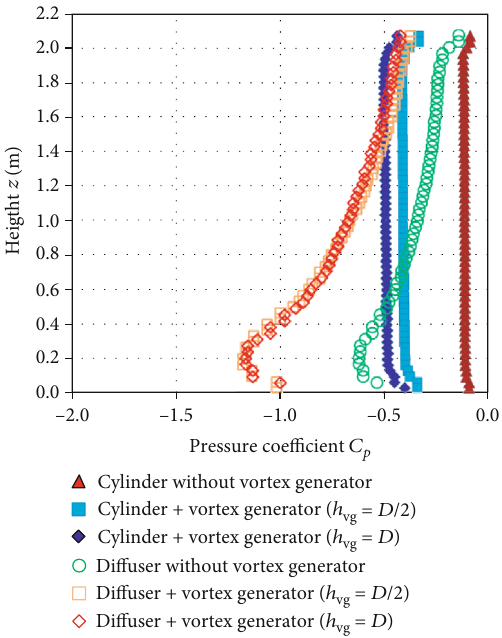
Figure 12: Pressure distributions in the towers (numerical results).